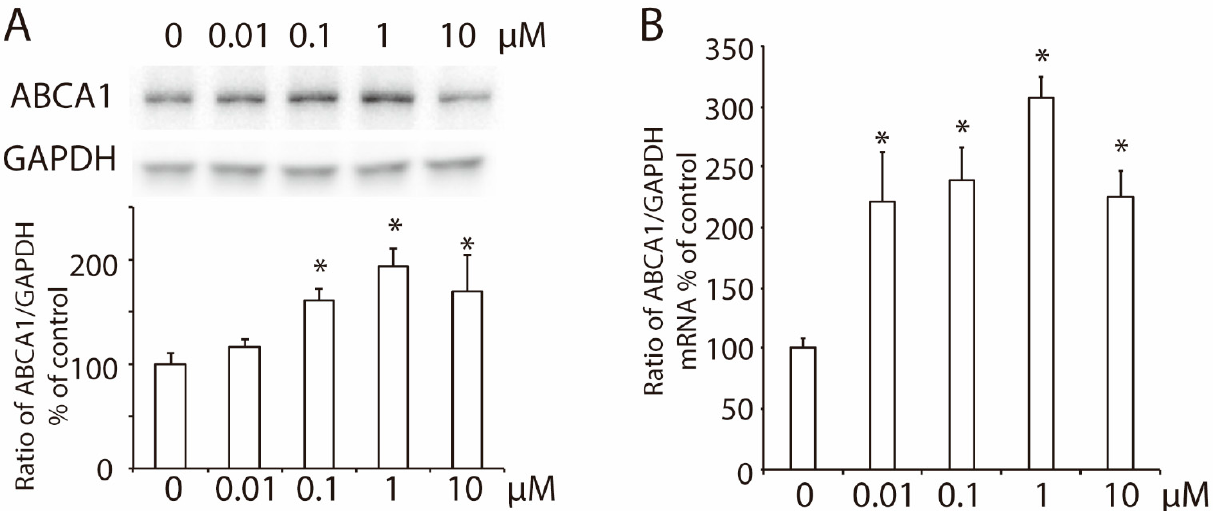
Figure 1. Effects of 2-ME 2 on the expression of ABCA1 in HepG2 cells. ( A ) ABCA1 protein expression in HepG2 cells treated with 2-ME 2 at varying doses for 24 h. ( B ) Effect of 2-ME 2 on the mRNA level of ABCA1 expression. An abundance of GAPDH served as the control, and the relative expression of ABCA1 to GAPDH is shown as a percent of the control in the histogram. The histogram shows the mean ± SEM ( n = 3) of separate experiments for each group. * p < 0.05 compared to 0.